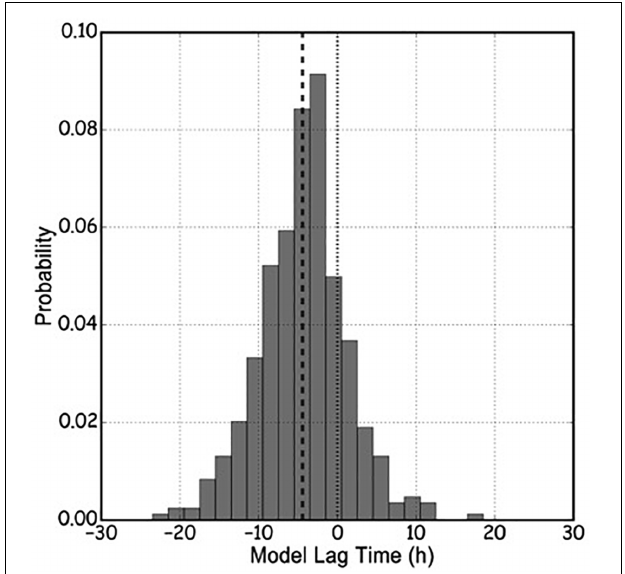
FIGURE 2 | Histogram of relative swell arrival time, model versus buoy observations. Negative values correspond to model predictions being early [Figure is reproduced from Babanin and Jiang